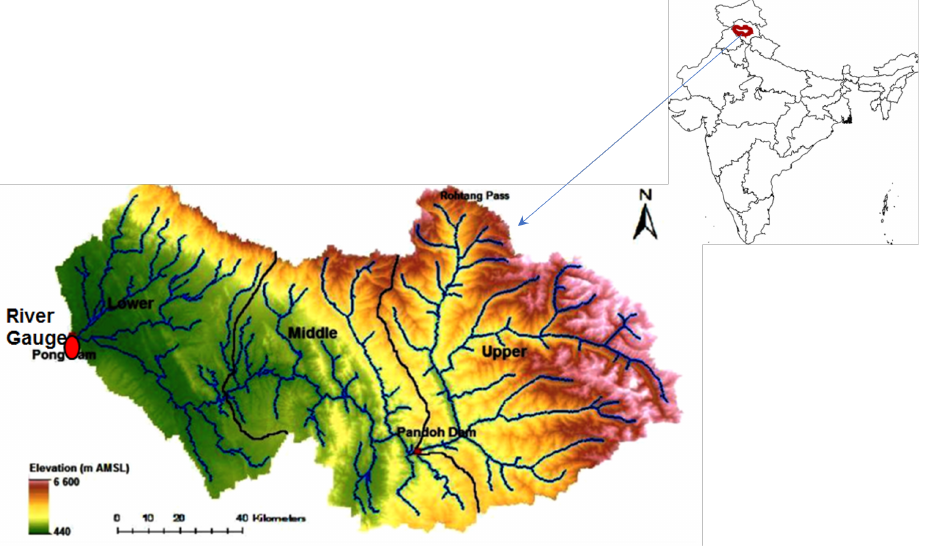
Figure 1. Map of Beas river